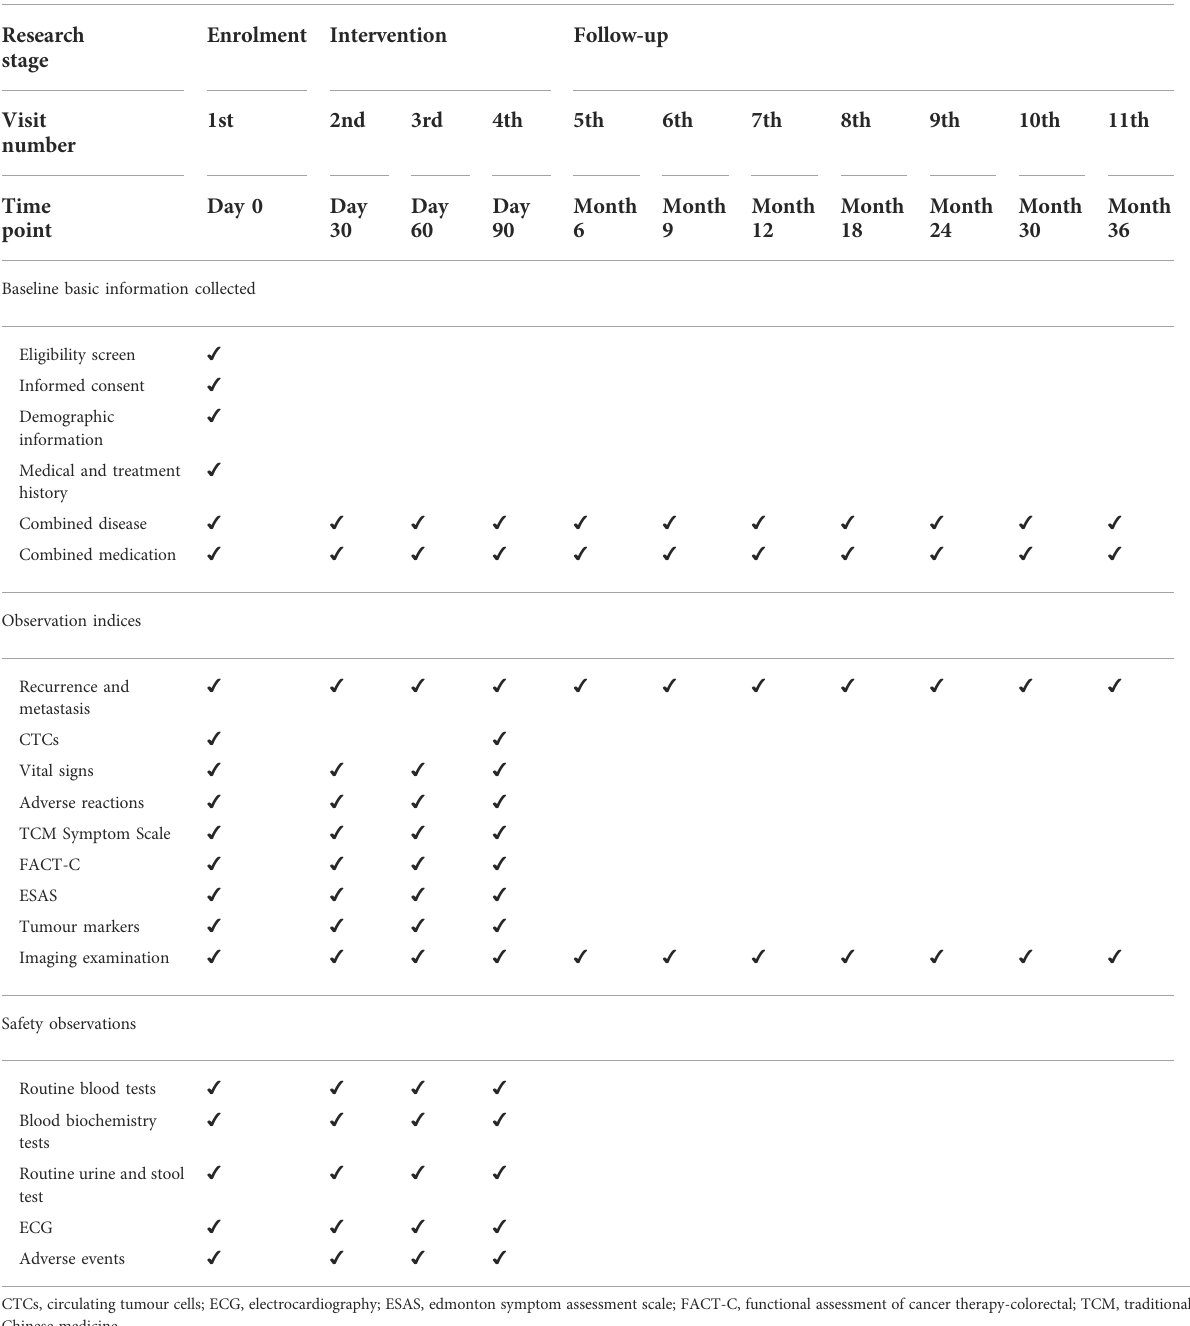
TABLE 2 Study data collection